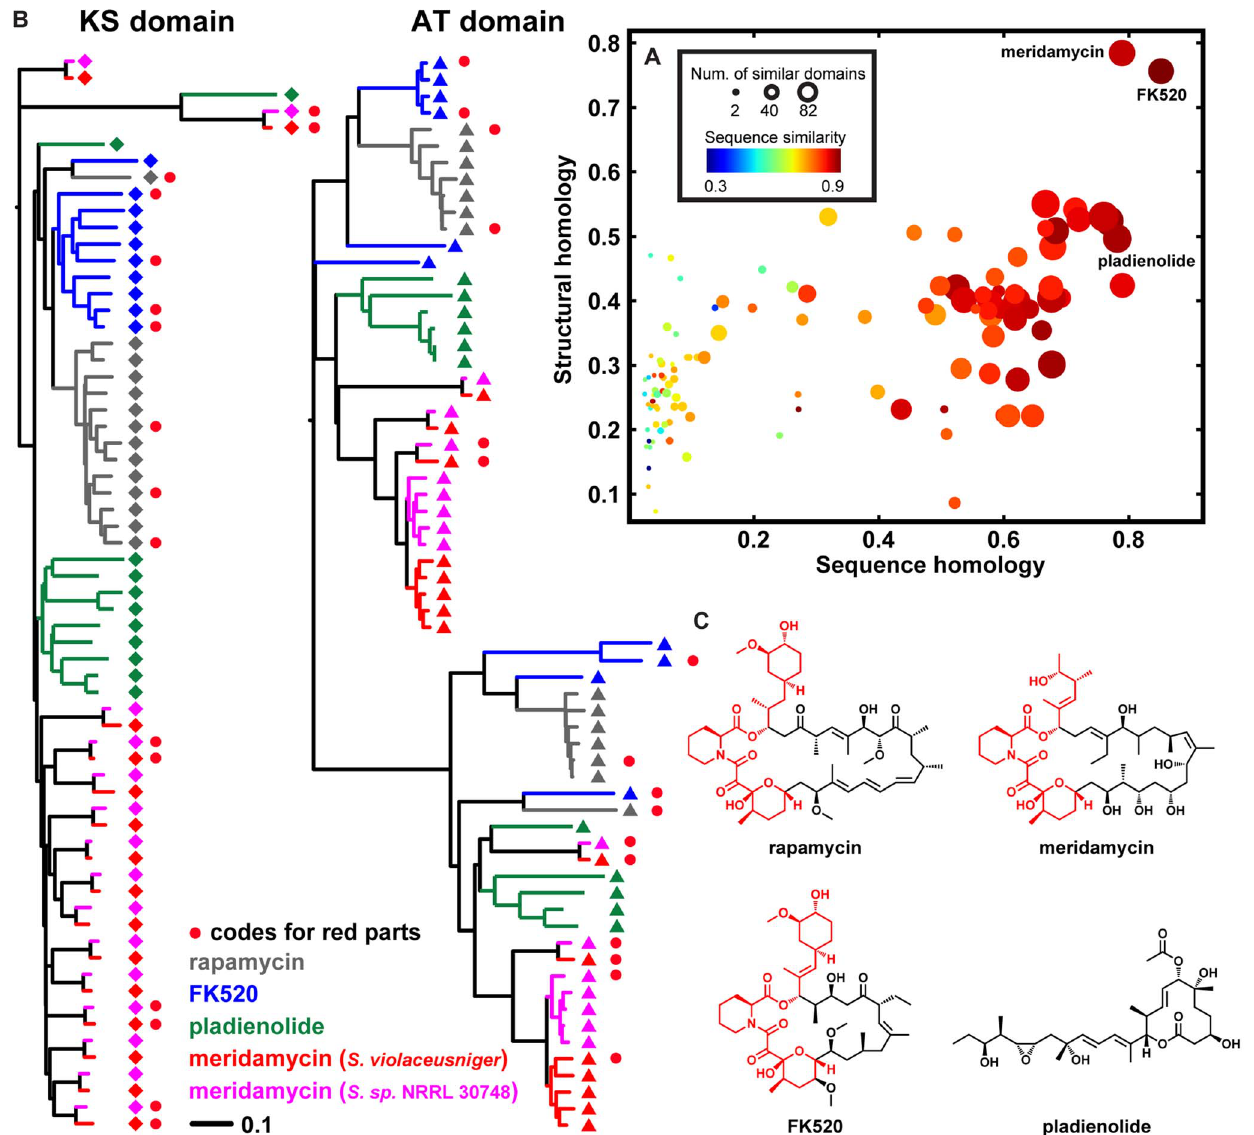
Figure 3. Unexpected evolutionary relationships within the rapamycin family. a , Distinct scaffolds produced by pathways from related BGCs. The scatter plot shows the relationship between the sequence homology of a pair of BGCs (x-axis) and the structural homology of their small molecule products (y-axis), compared to rapamycin and its BGC. Each circle represents a gene cluster and its small molecule product. Meridamycin and FK520 are closely related to rapamycin, as are their BGCs. While the pladienolide BGC is closely related to the rapamycin BGC, the structure of pladienolide itself is not very similar to that of rapamycin. In particular, pladienolide has a much smaller macrocycle and lacks shikimate- or pipecolate-derived moieties, and, as a result, binds to a distinct protein target. Structural similarity is estimated by the Tanimoto coefficient using linear-path fingerprints (FP2) from Open Babel [67], while sequence homology is represented as the Jaccard index defined on pairs of Pfam domains that share sequence identities within the top 10 th percentile of all-pair sequence identities. The number of domain pairs that share sequence identities within the top 10 th percentile and sequence identity of all domain pairs are shown as point sizes and colors, respectively. b , The role of concerted evolution in homogenizing domains within a BGC. Phylogenetic trees of KS and AT domains from the rapamycin, FK520, meridamycin, and pladienolide BGCs are shown (for detailed trees with accession numbers and bootstrap values, see Figure S11 ). The KS and AT sequences largely cluster into BGC-specific clades; for the AT domains, this is even the case for two different clusters encoding the same compound (meridamycin), showing the ability of concerted evolution to homogenize domains within a BGC. c , Chemical structures of rapamycin, meridamycin, FK520 and pladienolide. The sub-structure shared among rapamycin, meridamycin and FK520 is colored red, and the domains responsible for the biosynthesis of this sub-structure in each molecule are indicated with red circles in b .